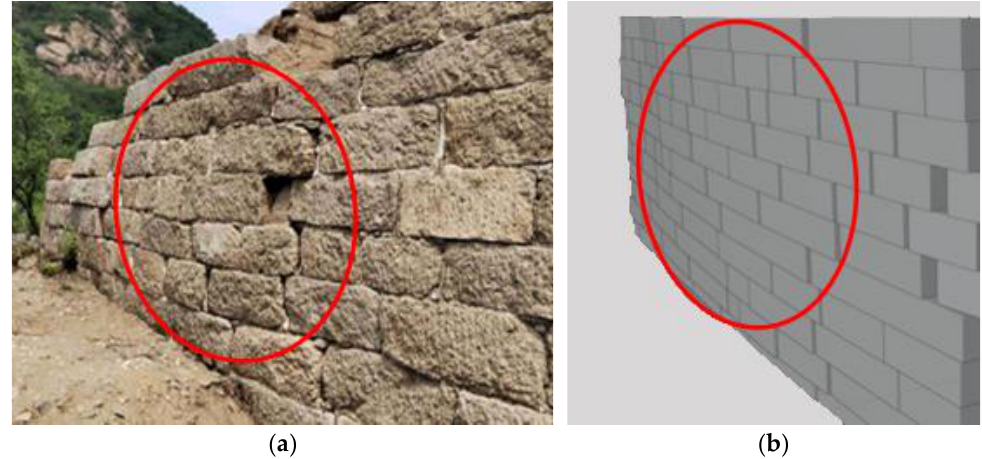
Figure 17. Comparison of base wall bulging: ( a ) Site picture; ( b ) Simulation.